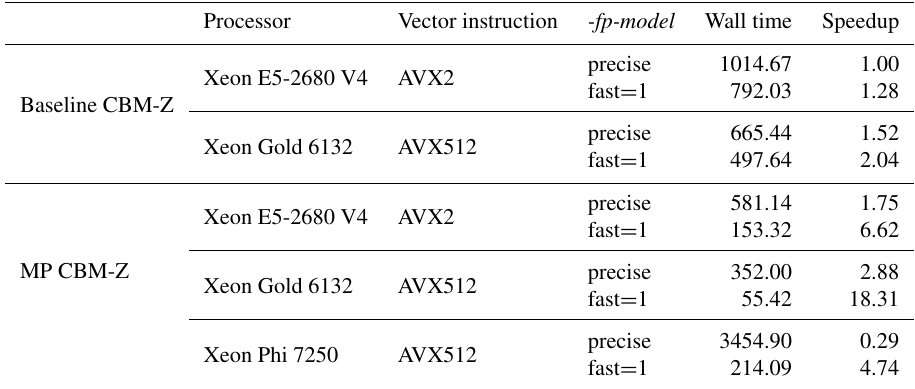
Figure 4. Comparison of the time-series concentrations of O 3 , NO, NO 2 , H 2 O 2 , SO 2 , OH, HO 2 , RO 2 , and H 2 SO 4 (a–i) from the baseline and optimized CBM-Z simulation with diverse -fp-model options. The simulation results by the baseline code with the -fp-model precise compile flag was as the benchmark. The solid lines show the time-series concentrations of the species from different experiments and the dashed lines showed the relative errors (RE) of simulated concentrations between the benchmark and the results by other combinations of the code and -fp-model options. Table 4. The performance tests of the baseline and optimized code on different CPUs and KNL platforms with one physical cores. The unit of the wall times for the tests is seconds